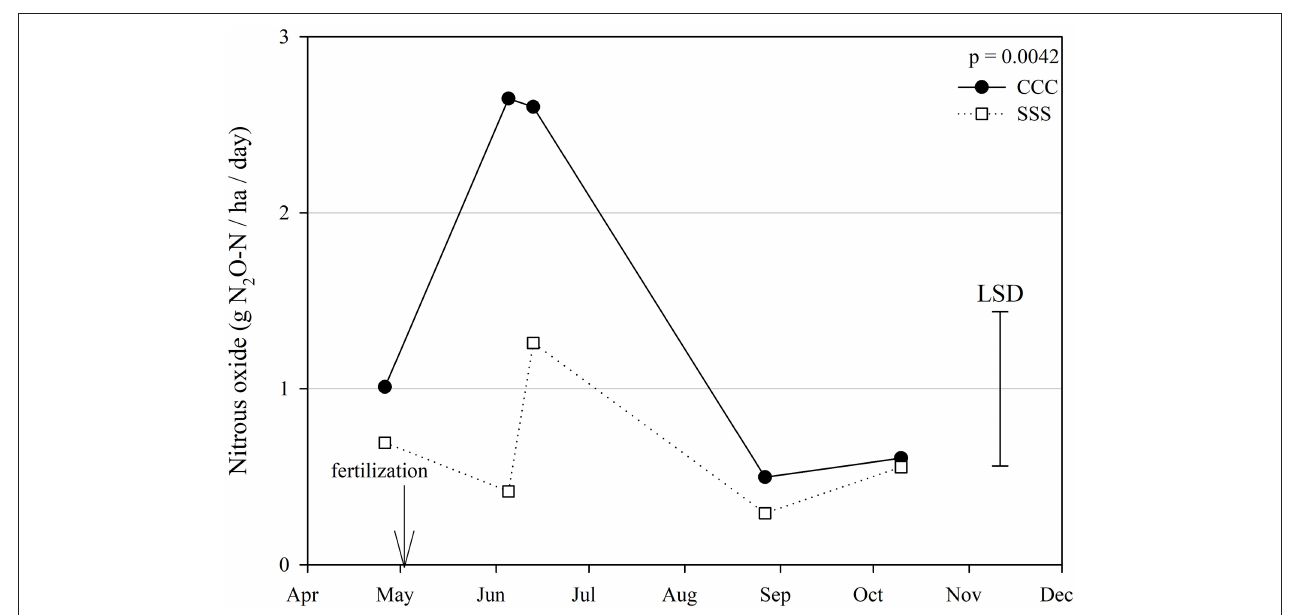
error bar to the right of the figure. Mean values that fall beyond the distance of the LSD are significant at α = 0.10.